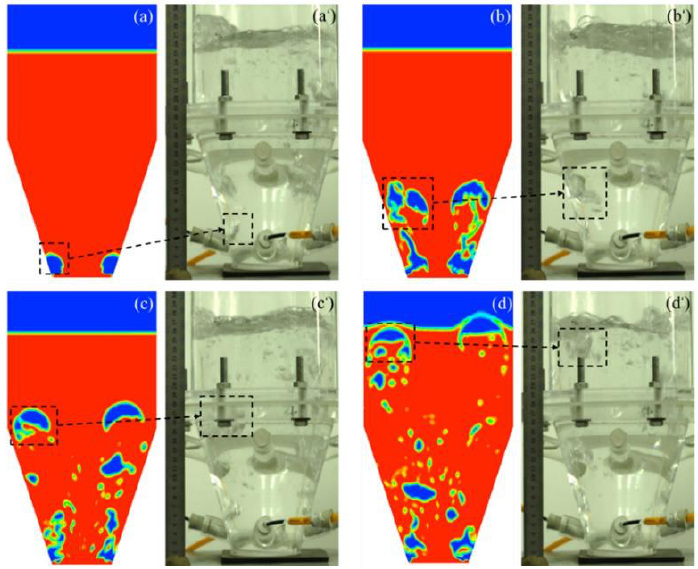
Figure 3. Comparison of simulation results and experimental results of the bubbles ’ rise ( left : simulation model(a, b, c, d), right : water model (a’, b’, c’, d’) ).